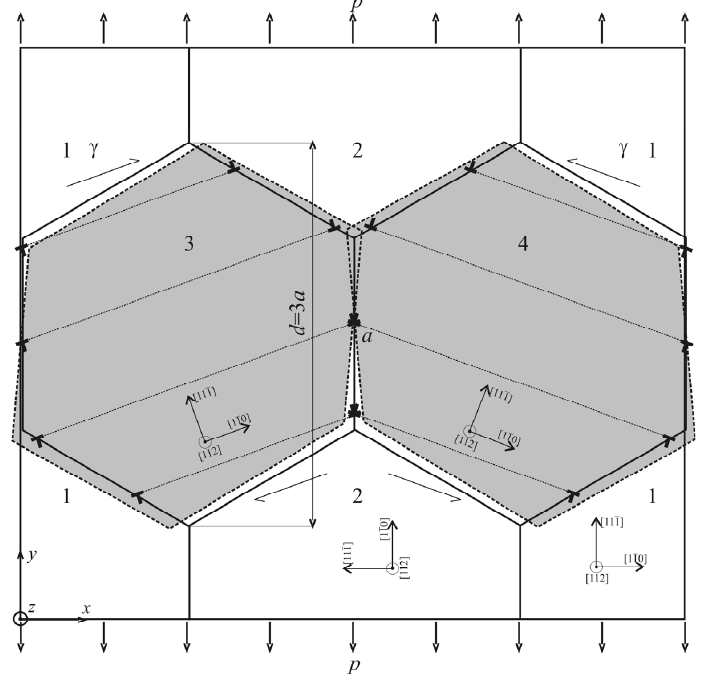
Figure 24. Schematic rendering of the computation cell for columnar fcc nanocrystals with a [112] axis and the formation of EGBDs due to shear strains of its two grains. Figures 1 to 4 denote the numbers of grains [120]. Table 3 summarizes the values of the defect energy 𝐸 (cid:3031)(cid:3032)(cid:3033) and excess energy 𝐸 (cid:3032)(cid:3051) of